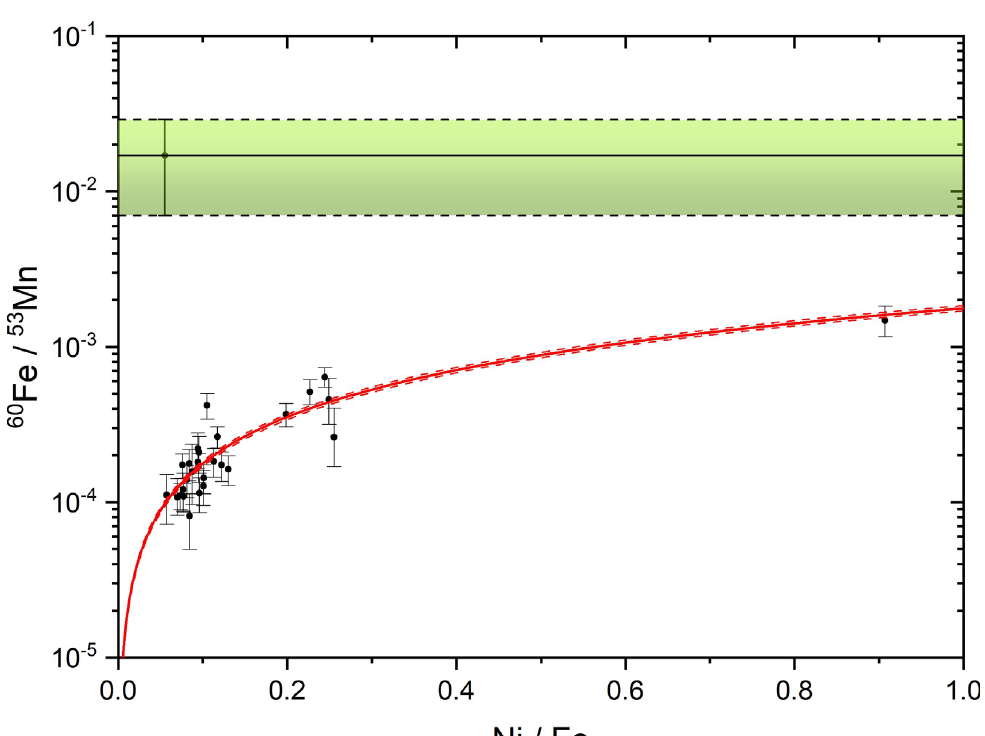
Figure 1: Antarctic snow data [8] in green with the updated, independent meteorite model in red and available meteorite data in black [9]. The enhancement of 60 Fe over the expected cosmogenic ratio is clearly visible. The datapoint is exemplarily displayed for the most likely stable element abundance Ni / Fe =